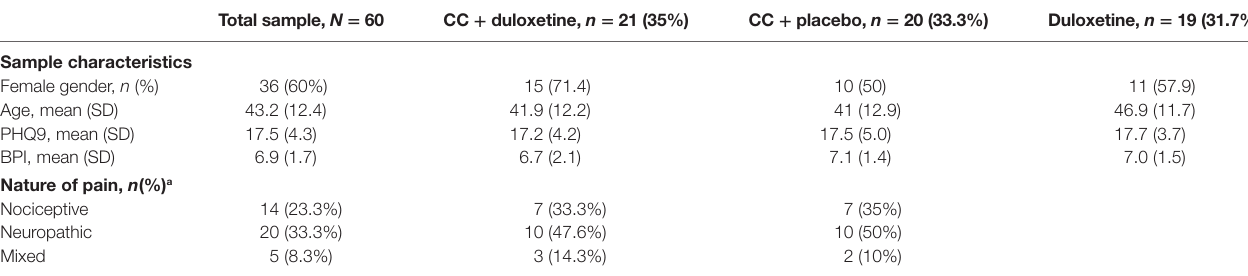
TaBlE 1 | Gender, age and mean of pain, and depressive symptoms at baseline of the total sample and three treatment conditions. Total sample, N = 60 CC + duloxetine, n = 21 (35%) CC + placebo, n = 20 (33.3%) Duloxetine, n = 19 (31.7%) Sample characteristics Female gender, n (%)